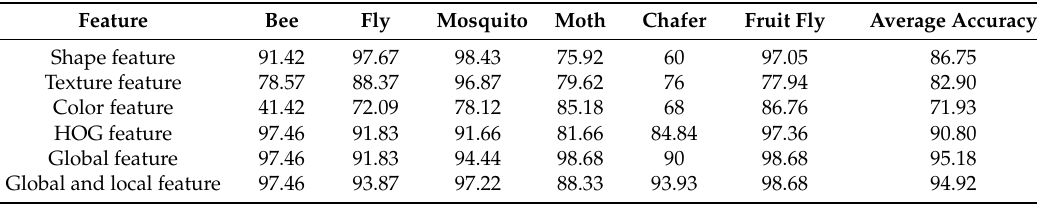
Table 3. Classification accuracy of SVM (Unit: